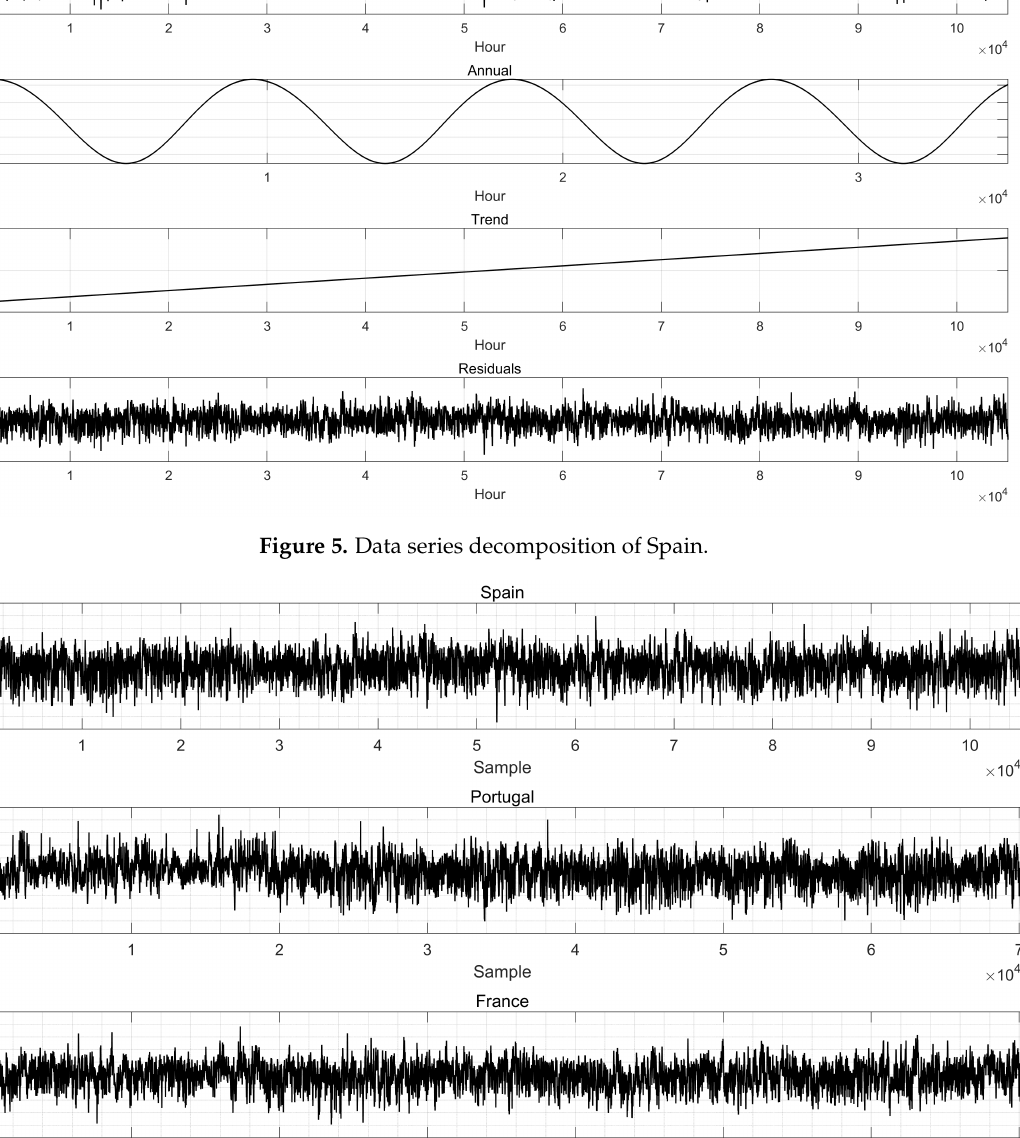
Figure 6. Remaining component obtained after data decomposition for each